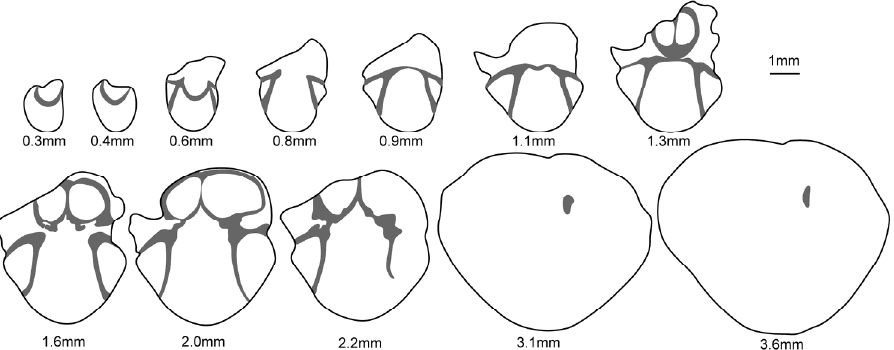
Figure 9. Serial sections of Sulcatinella elongata sp. nov., LD384907. Description. Shell medium to large in size for genus, 9.16–16 mm in length and 7.19–12.5 mm in width (12 specimens measured), elongated rhombic to subpentagonal in